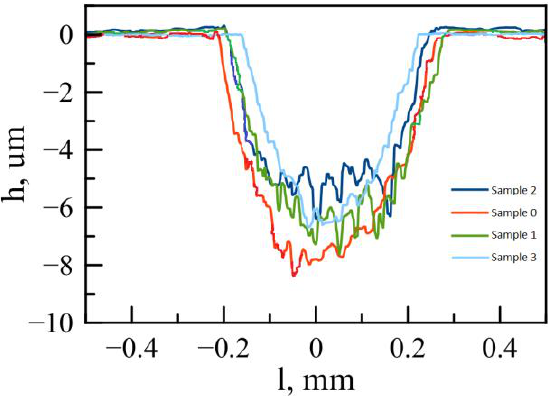
Figure 7. Profiles of the sample wear grooves.